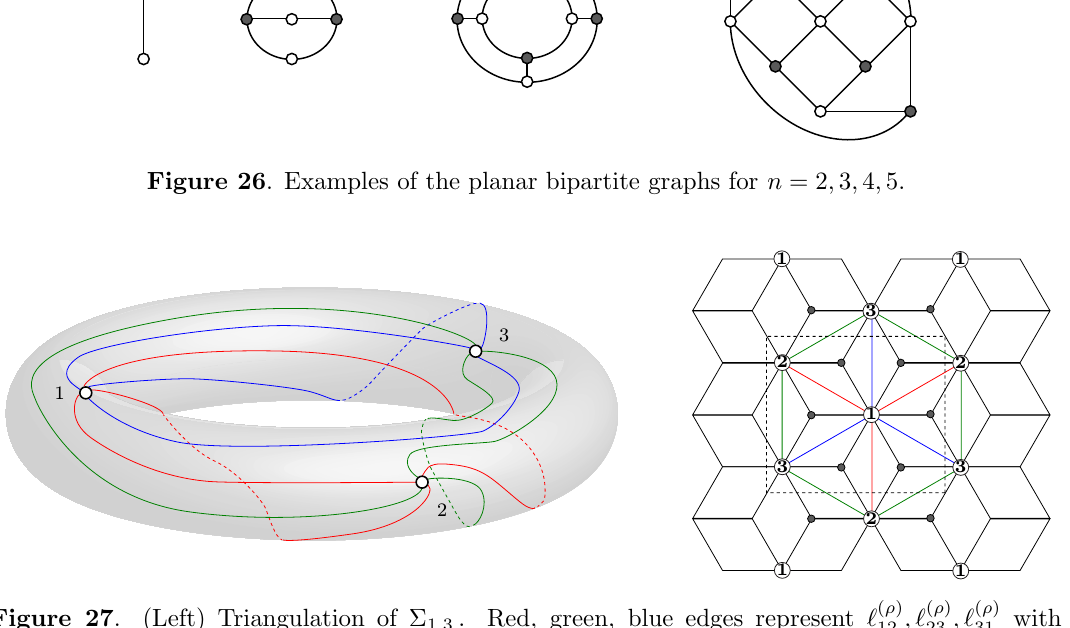
Figure 27 . (Left) Triangulation of (cid:6) 1 ; 3 . Red, green, blue edges represent ‘ ( (cid:26) ) (cid:26) = 1 ; 2 ; 3, respectively. (Right) The same geometry as a toric bipartite graph. The fundamental region is denoted by the dotted